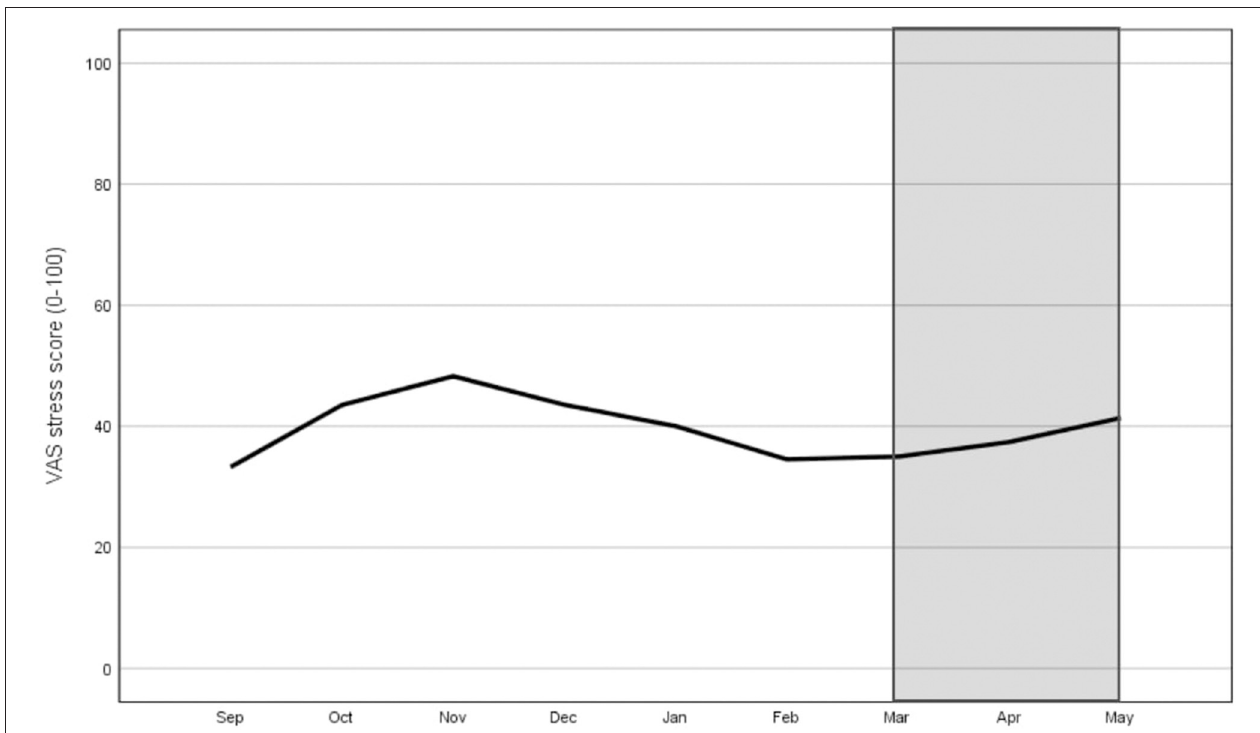
FIGURE 1 | Monthly stress score (VAS scale ranging from 0 to 100) during the pre-COVID-19 period (Sep-Feb) and during the COVID-19 lockdown (Mar-May: grey area).